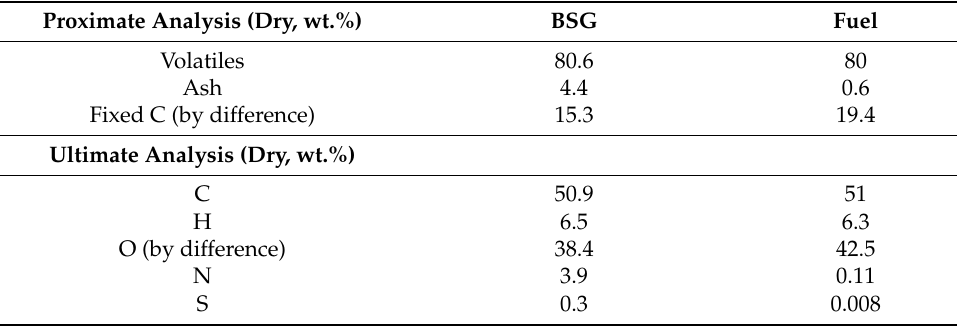
Table 1. Characterization of brewery spent grains (BSG) and wood pellets (Fuel). Proximate Analysis (Dry,